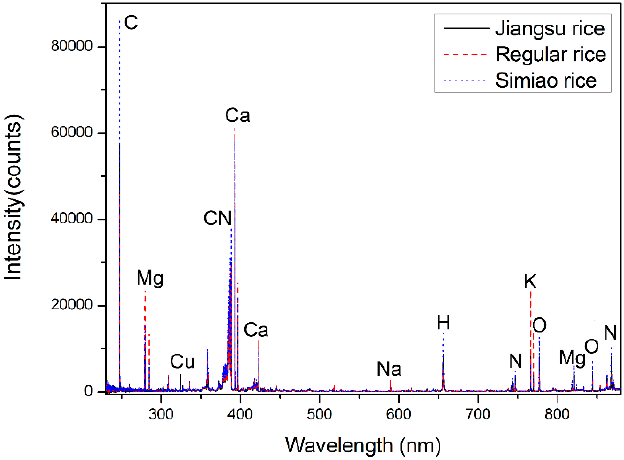
Figure 2. LIBS spectra of three different kinds of rice. Raw spectra of three different kinds of rice without extra added Cu.